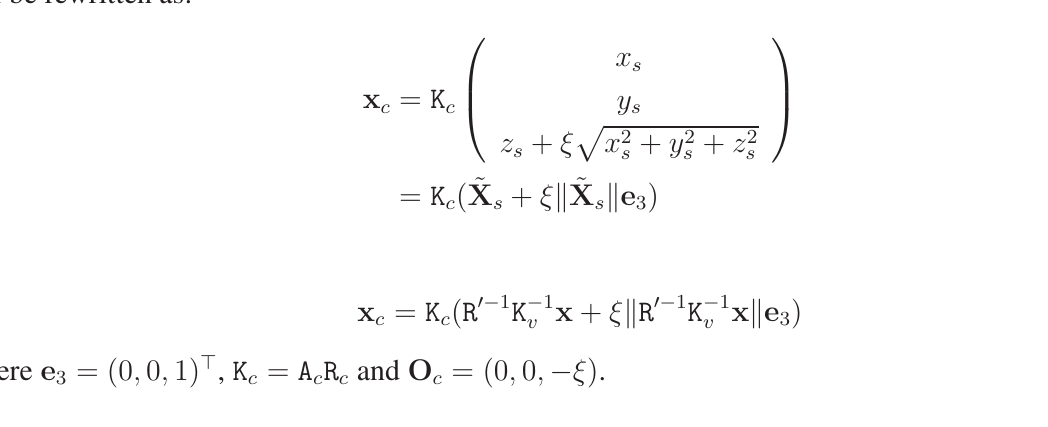
Figure 3. Catadioptric image formation model via a unit sphere used for virtual camera construction. The origin of the common coordinate frame O is the projection center of both catadioptric and virtual